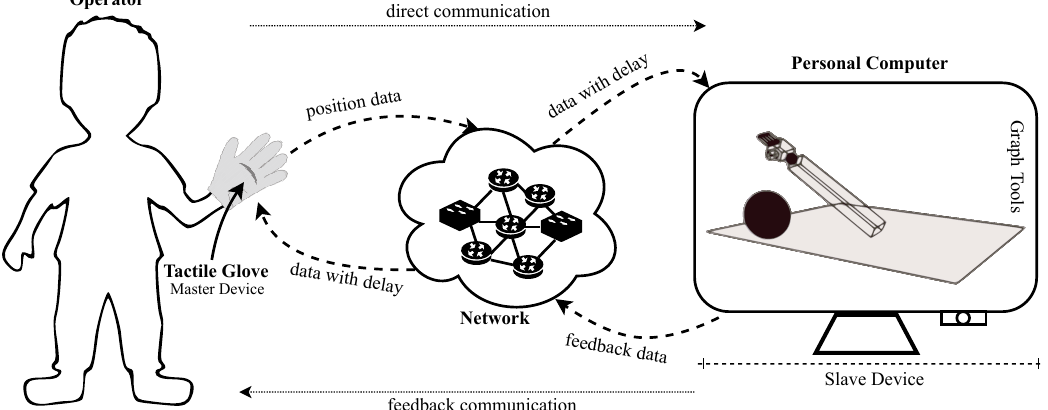
Figure 1. High-level block diagram of the human-to-machine tactile system.